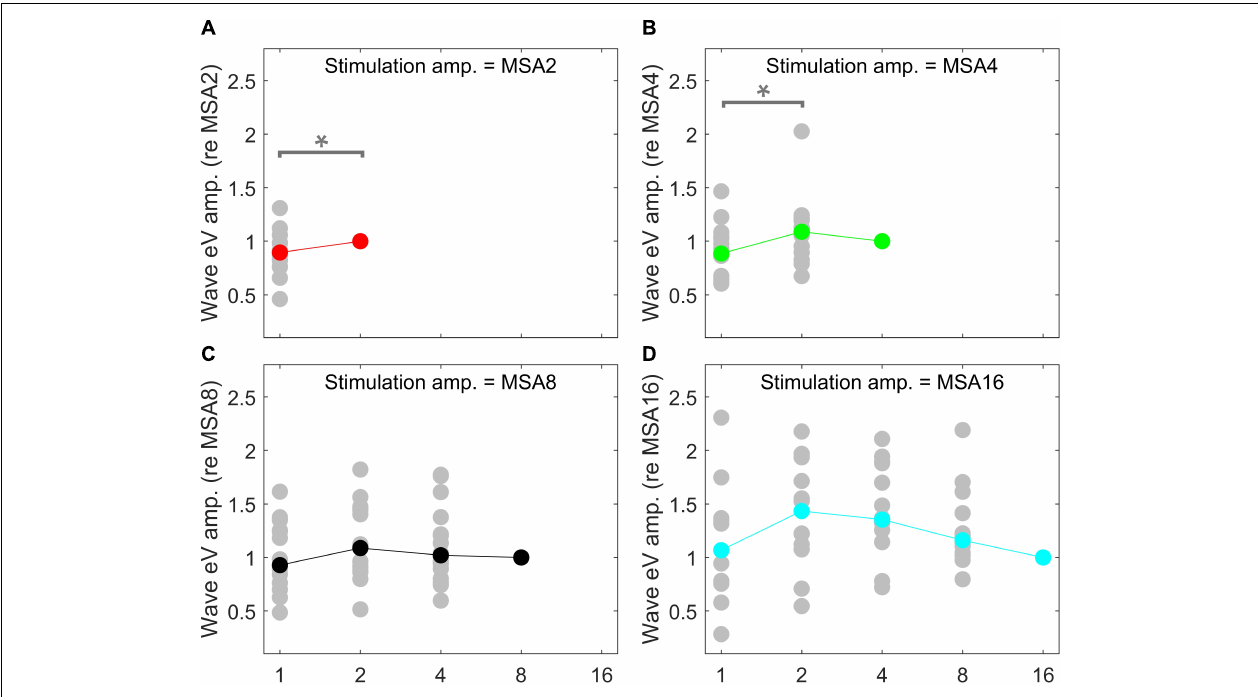
FIGURE 9 | eABR eV amplitudes of multi-pulse conditions over all subjects. In each panel, the stimulation amplitude is constant [MSA2, MSA4, MSA8, MSA16 in panels (A–D) , respectively]. Data from individual subjects are plotted in gray circles and their corresponding median values in colors, which match the colors in Figure 7 . In each panel, data were normalized to (divided by) the corresponding responses at the largest number of pulses [2, 4, 8, and 16 pulses in panels (A–D) , respectively]. Data of the MSA1 condition (blue points in Figure 7 ) are not plotted, as all were 1 due to normalization. The asterisk shows pairs with significant